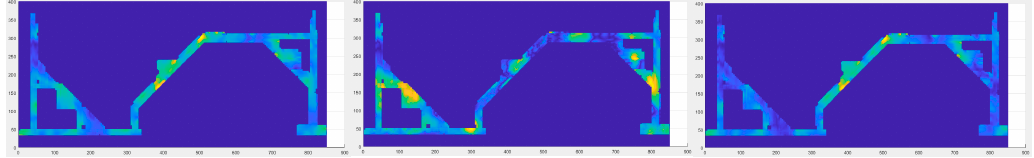
Figure 9. Magnetic fingerprint map of three elements in the testing area ( μ T).